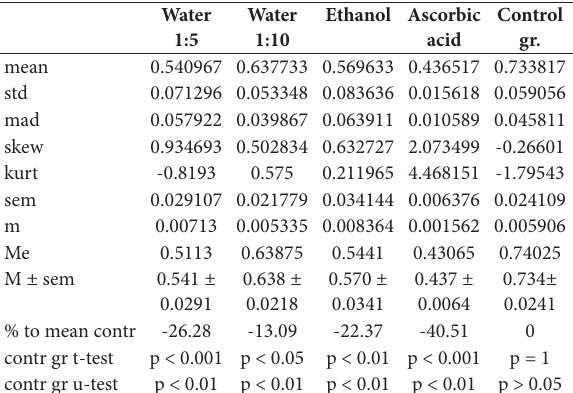
Table 2. Descriptive statistics of thiobarbituric acid reactive substances (TBARS) in samples T. pratense